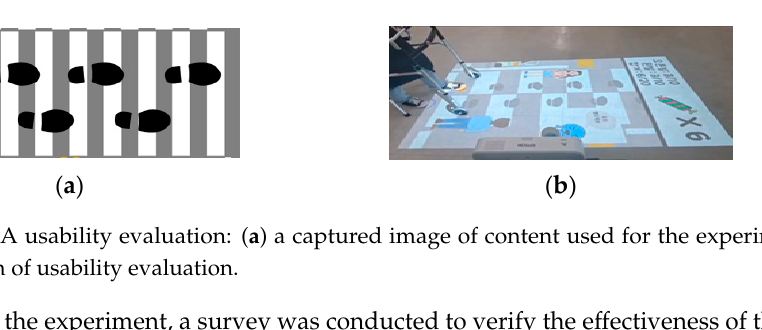
Table 2. Questionnaire used for usability evaluation. No